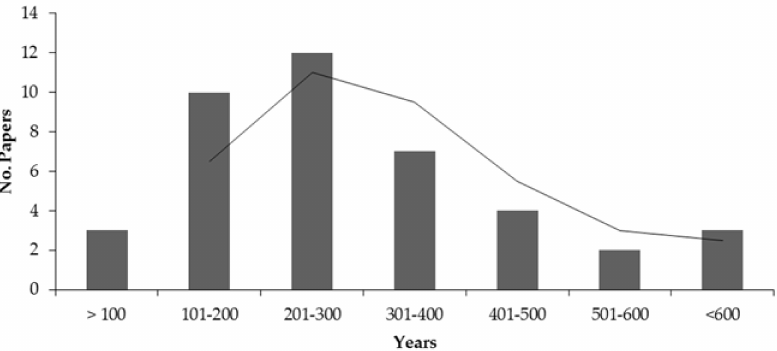
Figure 10. Dendrochronological studies performed in Mexico and grouped according to the amplitude or length of the